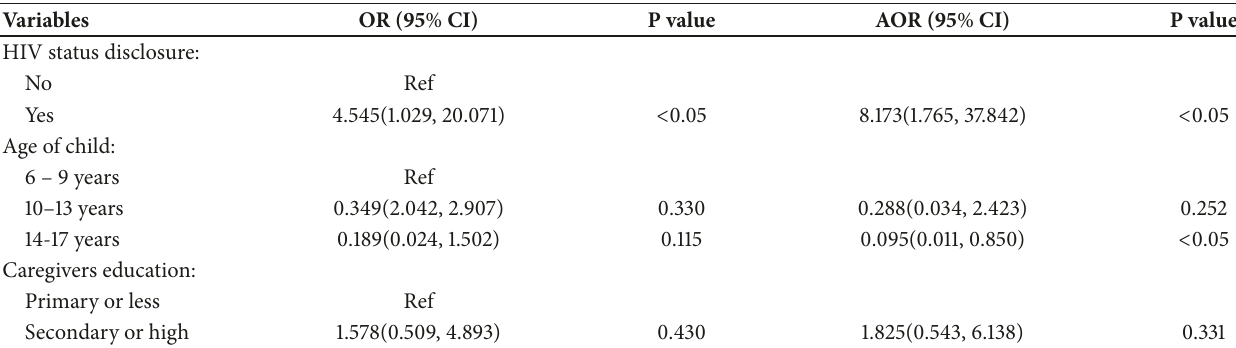
Table 5: Crude and adjusted analysis for the association between HIV status disclosure and ART adherence, among children between 6 and 17 years on antiretroviral therapy in Southern Highlands Zone, Tanzania